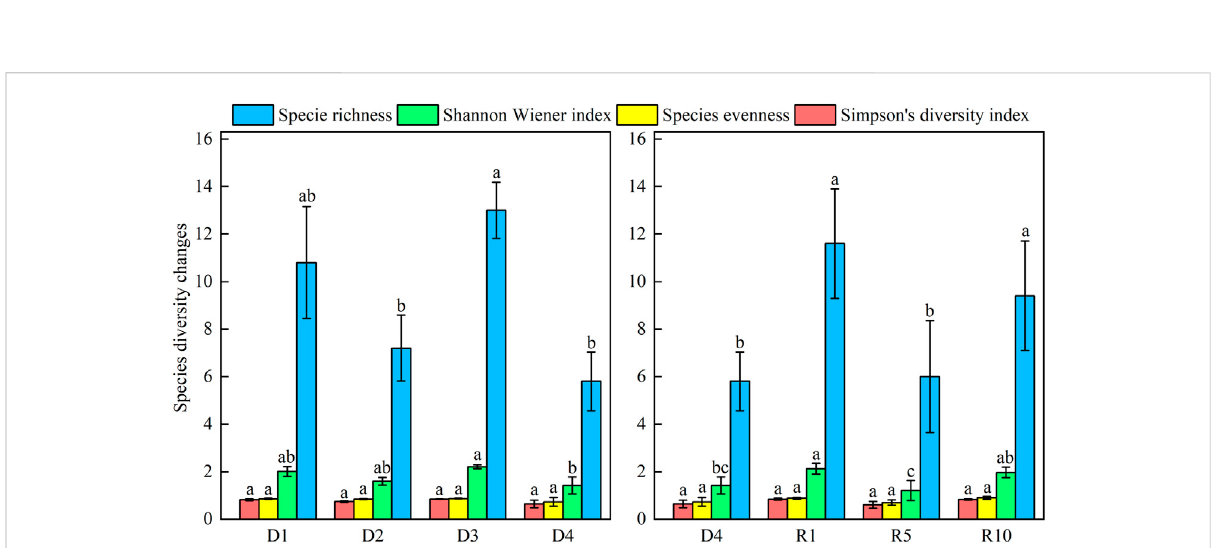
FIGURE 4 Changes in the species diversity of plant communities at different degradation stages and different recovery durations. Note: Different lowercase letters represent signi fi cant differences in species richness, Shannon ‒ Wiener index, species evenness index and Simpson diversity index between different degradation stages and recovery years ( p <